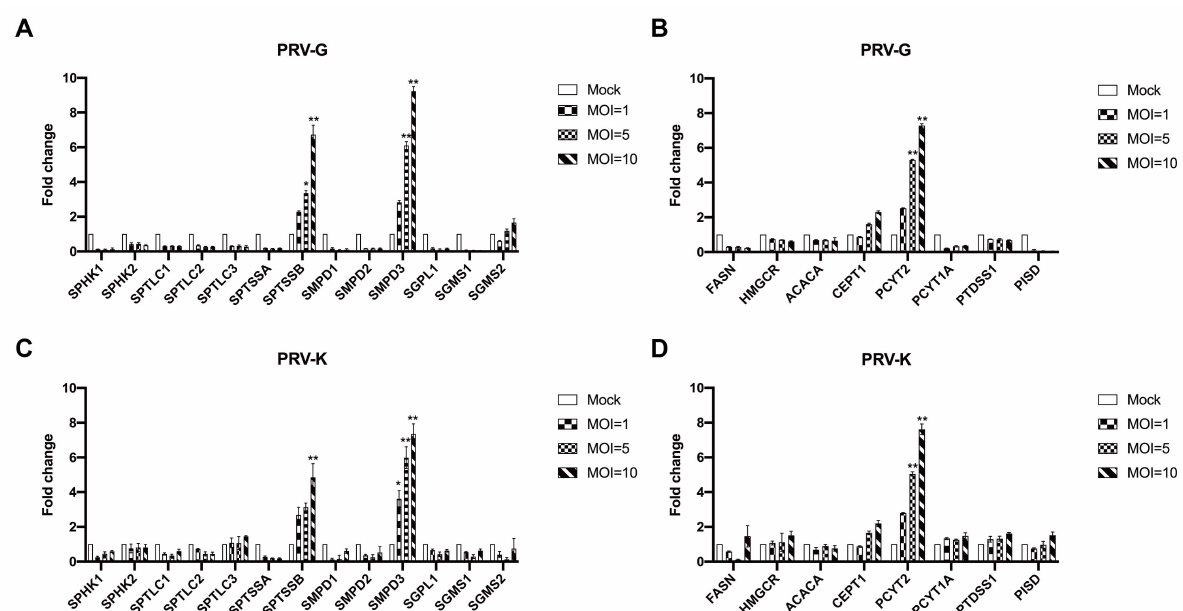
Figure 7. The mRNA levels of sphingolipid- and glycerophospholipid-metabolism-related enzymes after different PRV-strain infections. PK-15 cells were harvested with different MOI (1, 5, 10) at 24 h.p.i after PRV (PRV-G or PRV-K) infection, while non-infected cells were used as control. The mRNA levels of different enzymes were determined by qRT-PCR. β -actin was used as an internal reference gene. ( A , B ) PRV-G; ( C , D ) PRV-K. The significance in the figure was indicated as follows: *, p < 0.05; **, p <